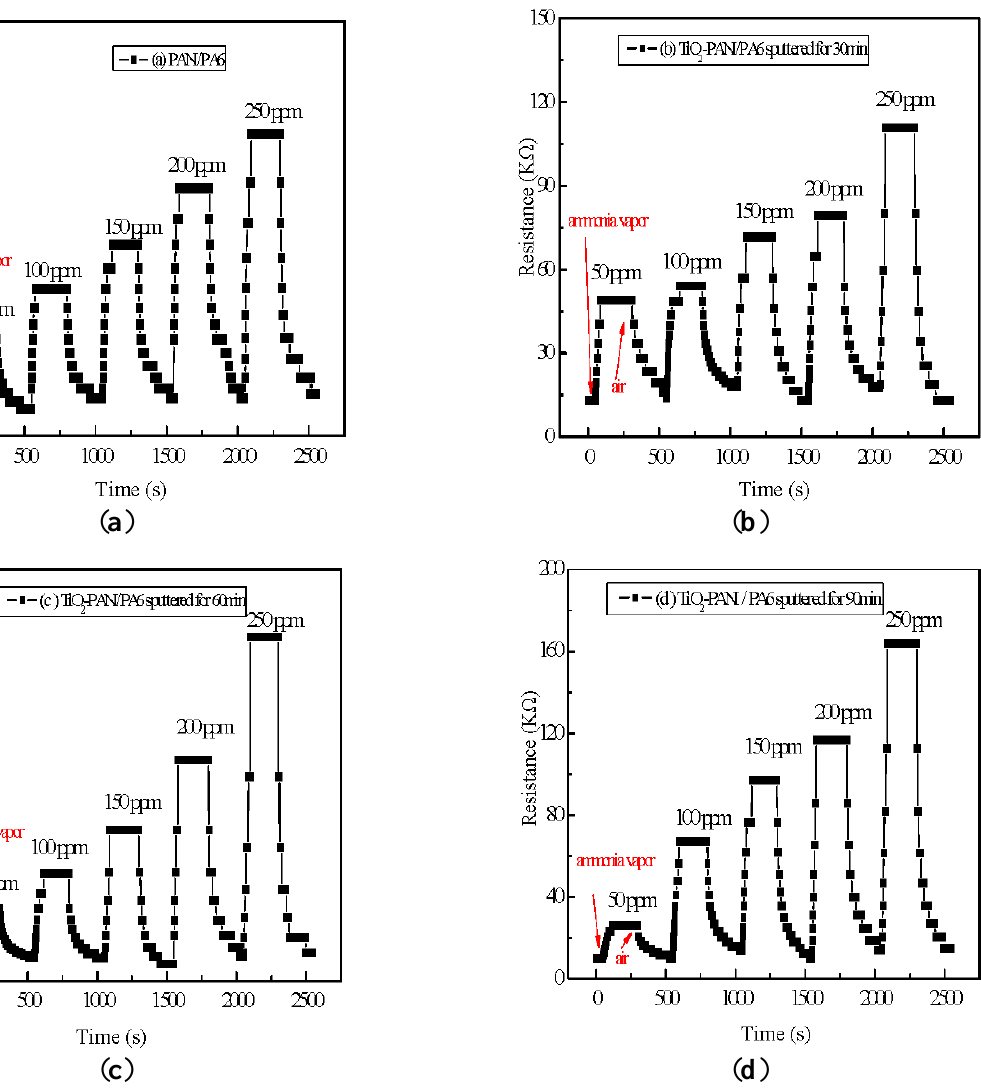
Figure 6. Dynamic response and recovery of ( a ) PANI/PA6; ( b ) TiO for 30 min; ( c ) TiO -PANI/PA6 sputtered for 60 min and ( d ) TiO 2 90 min to ammonia vapor of different